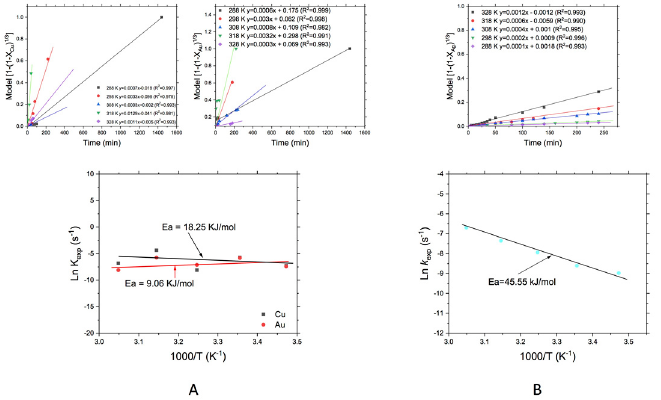
Figure 6. Leaching of; ( A ) Au and Cu from WEEE, and ( B ) Ag from MW: Effect of temperature.